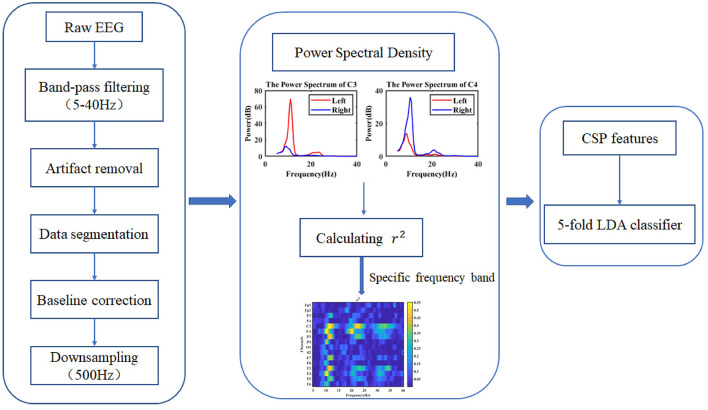
Overall diagram of electroencephalogram (EEG) signal processing.